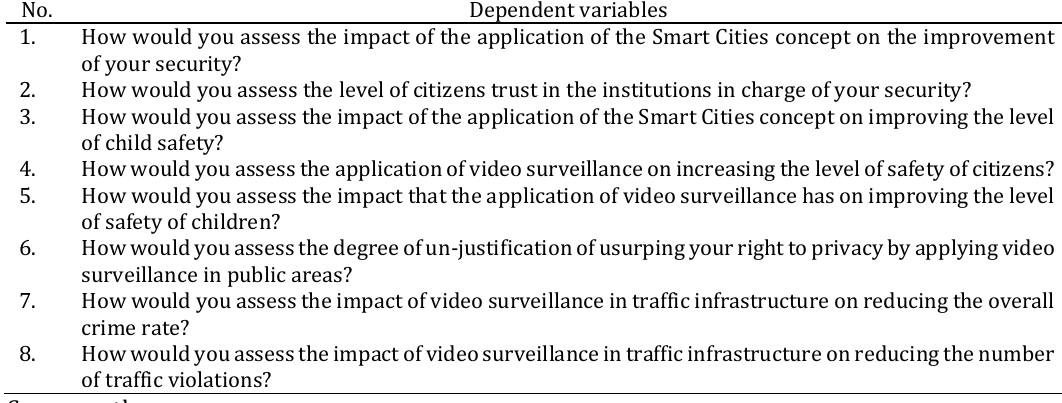
Table 1: Questions for experts (scale of 1-5)